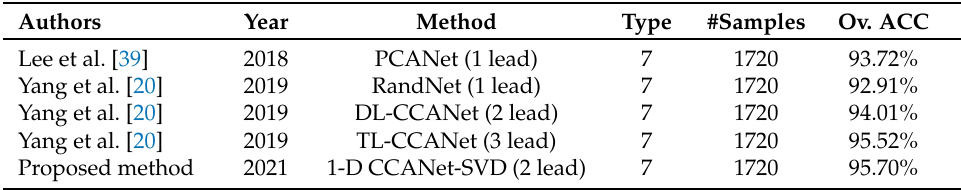
Table 8. Results for various methods on the INCART